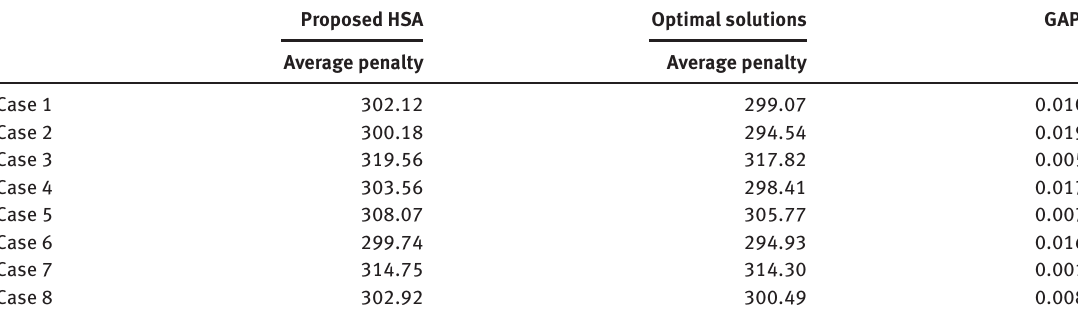
Table 11: Comparison between the Proposed Algorithm and Optimal